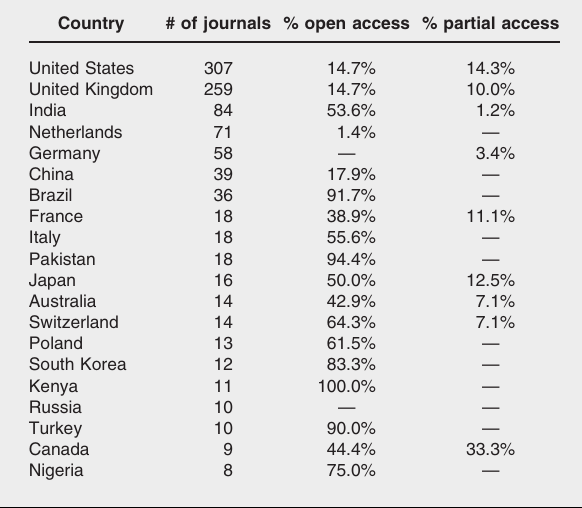
Table 3 Open access in 2013 for the 20 countries with the most One Health– related journals in this data journals with the most articles in the dataset appears in Table 2, online only.